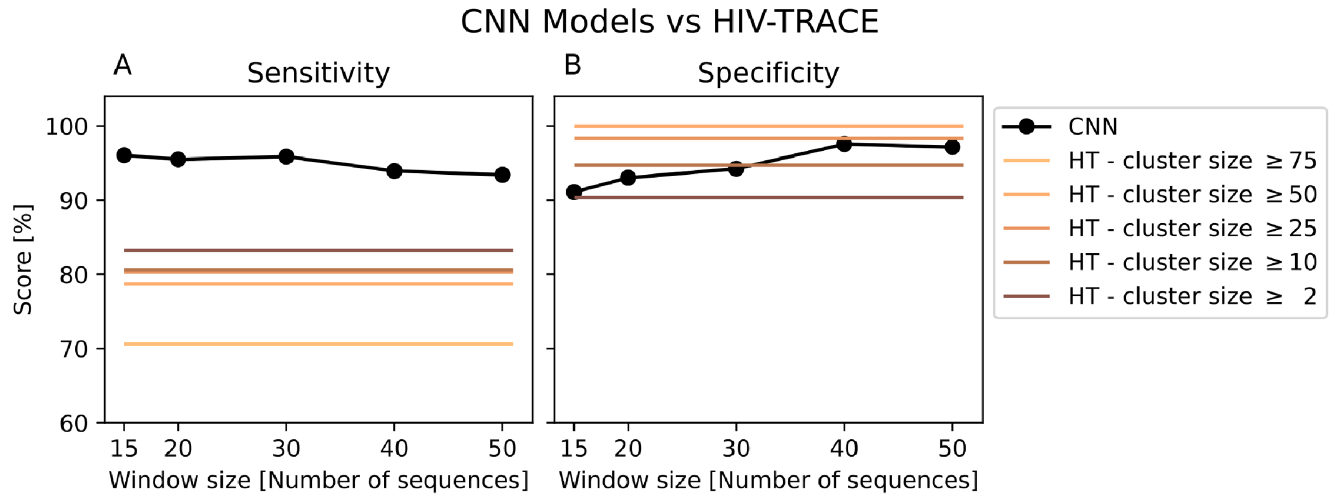
Fig 6. Sensitivity and specificity on the multiple-cluster test set of our method and HIV-TRACE. Model performance is computed using the same 60 matrices of 10 clusters each for a total of 60, 000 infections. (A) Sensitivity is high and exceeds all interpretations of HIV-TRACE output. (B) Specificity of the method increases as the window size increases and performs comparably to